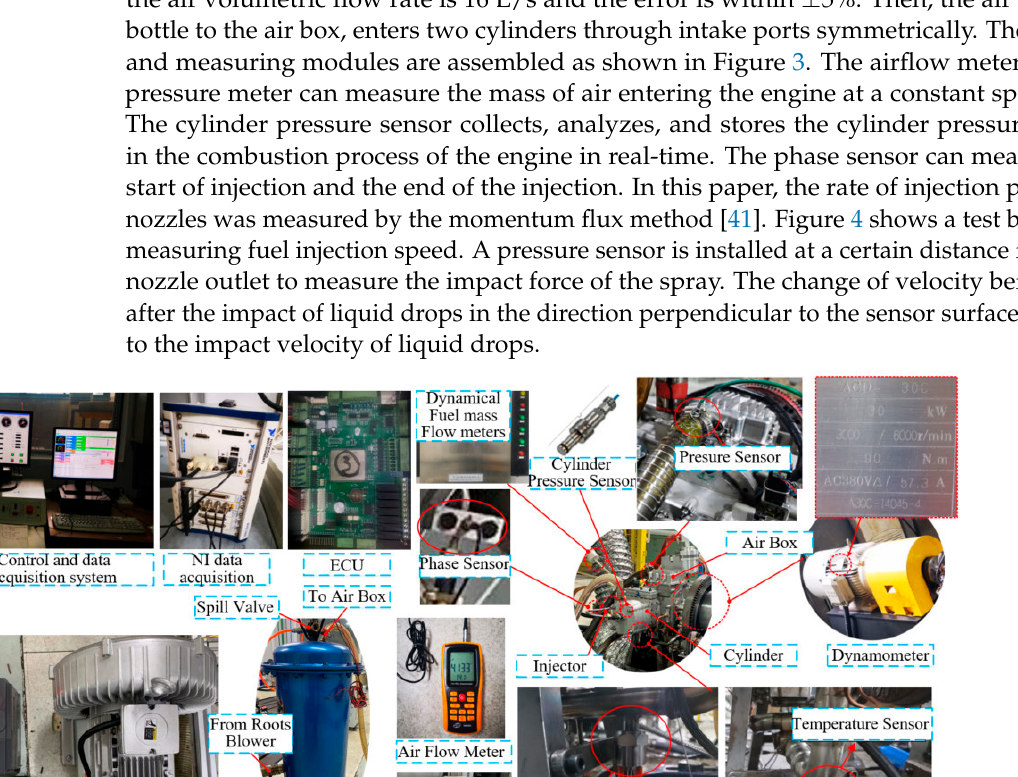
Figure 4. Rate of injection profile test bench. Detailed parameters are shown in Table 2.